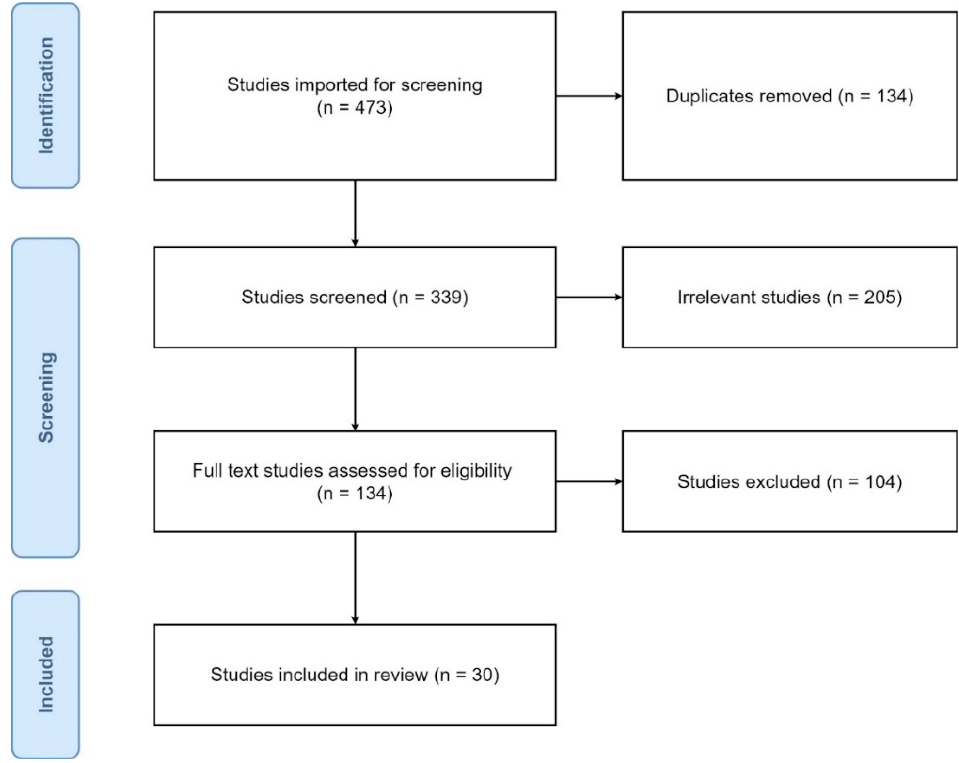
Figure 1. PRISMA flow diagram of literature search and selection process.